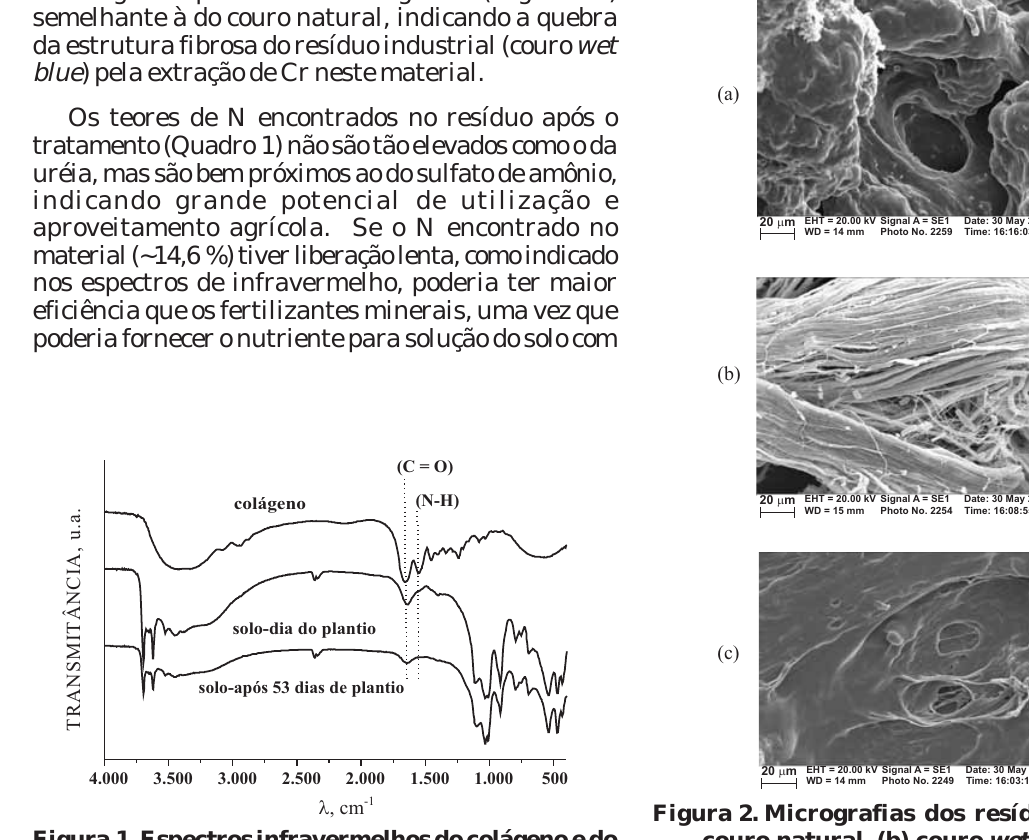
Figura 1. Espectros infravermelhos do colágeno e do solo contendo o couro como